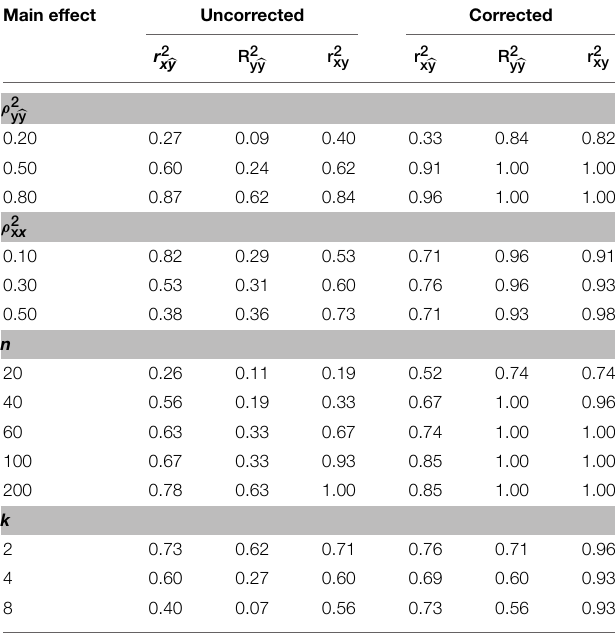
TABLE 3 | Proportions of cell conditions in which unbiased estimates observed across main effects. Main effect